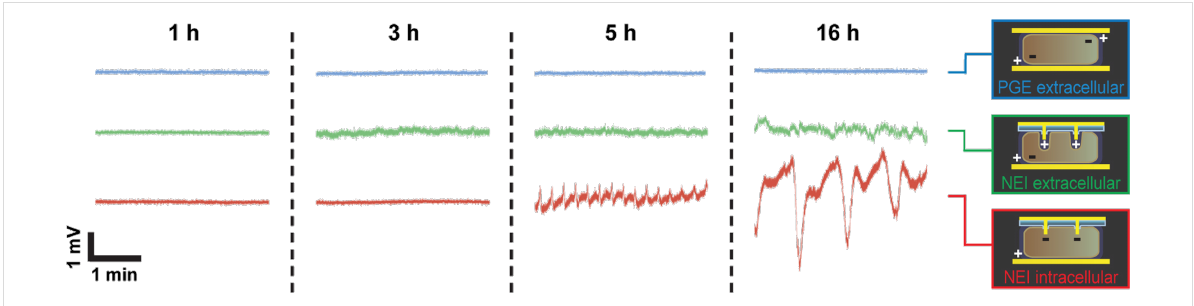
Figure 3: Membrane potential oscillations of Physarum p. measured with NEIs. Typical recordings from Physarum p. sandwiched between NEI/PGE or PGE/PGE surfaces are shown at the indicated time points after connecting the circuit to the electrical load. Membrane potential oscillations, presumably associated with the protoplasmic streaming activity of Physarum p. , were frequently detected after 3 h in the case of extracellular NEIs and (albeit less frequently) after 5 h in the intracellular configuration. Note that the signal amplitude has strongly increased in the later case. Repre- sentative recordings are